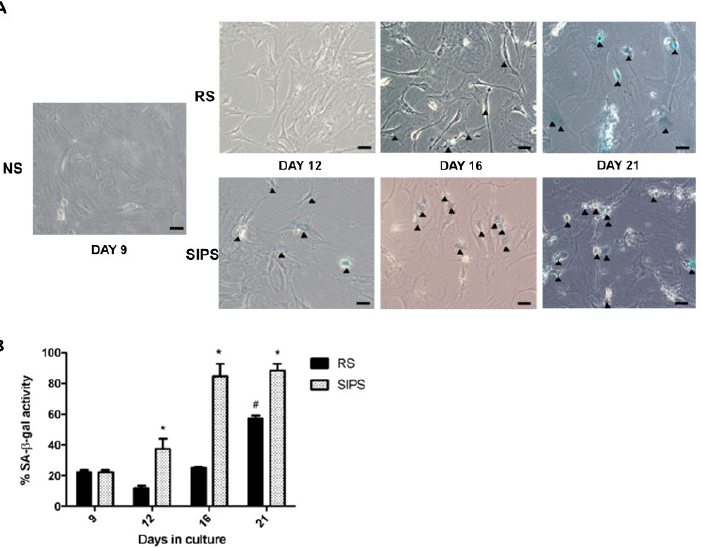
Figure 1. Senescence determination by SA-β-Gal assay. ( A ). Representative images of SA-β-Gal staining. NS proliferating cells, RS replicative senescence, SIPS stress-induced premature senescence. ( B ). Percentage of SA-β-Gal staining cells. The bars represent the mean ± SEM of stained cells from three independent experiments. Statistical significance # SR and * SIPS compared to NS (day 9) (*/# p < 0.05, ANOVA–Tukey-multiple comparisons test). Images are 40× with a scale bar indicating 20 μM. The arrows indicate positive blue staining of SC.